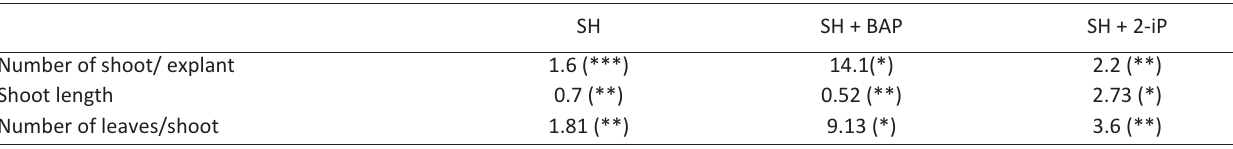
* indicate the statistical significance (p<0.05) using Z